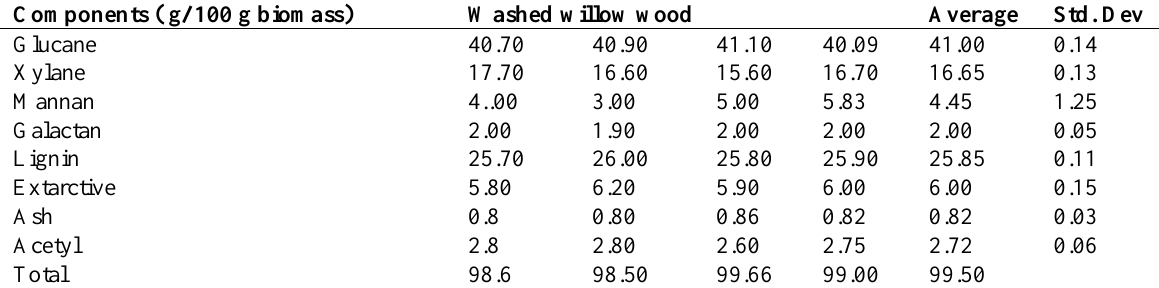
Table1, composition of raw willow wood feedstock.